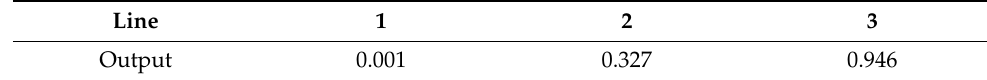
Table 4. Output of the FLS model for Figure 13.